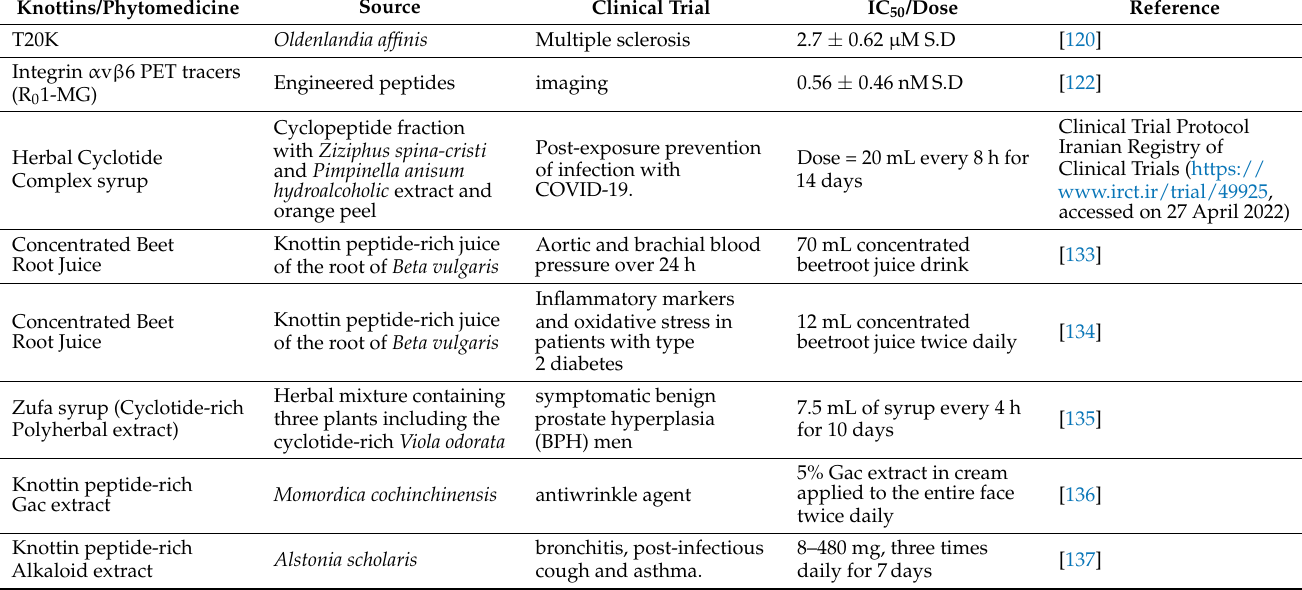
Table 3. Phytomedicines rich in knottin peptides and purified Knottin peptides from Botanical sources in clinical trials. Many of the observed clinical activities presented in the table have been attributed to other secondary compounds, while bioactive knottins present in the aqueous/alcoholic extracts have not been considered. This represents a huge gap for peptide drug discovery, warranting further